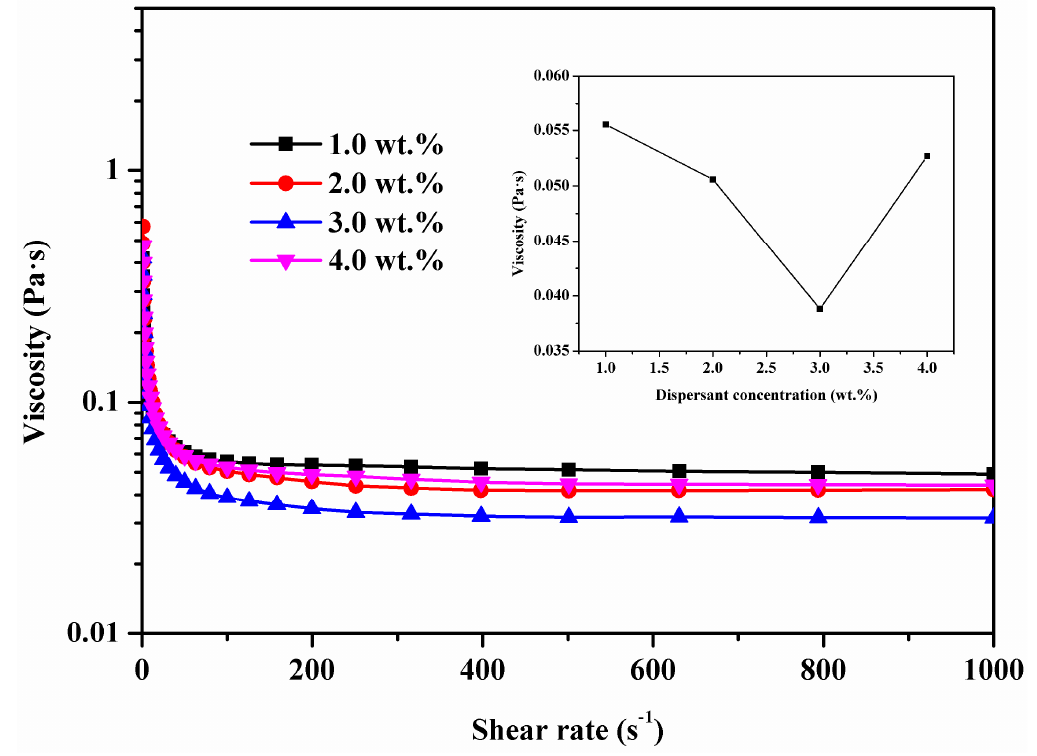
Figure 2. Viscosities of 35.0 vol.% KNN suspensions as a function of the dispersant concentrations.